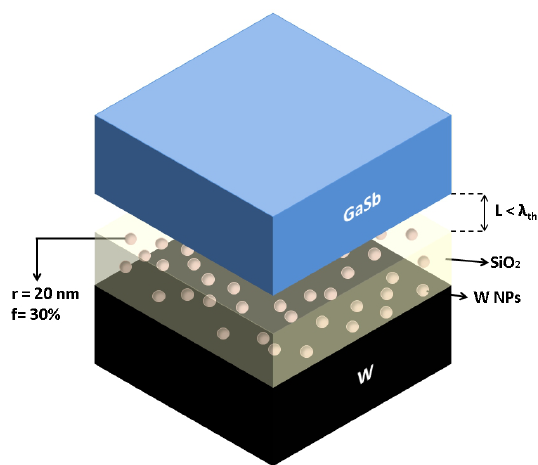
Figure 1. Schematic of near-field thermophotovoltaic system consisting of the proposed thermal emitter and GaSb-based PV cell at separation less than the thermal